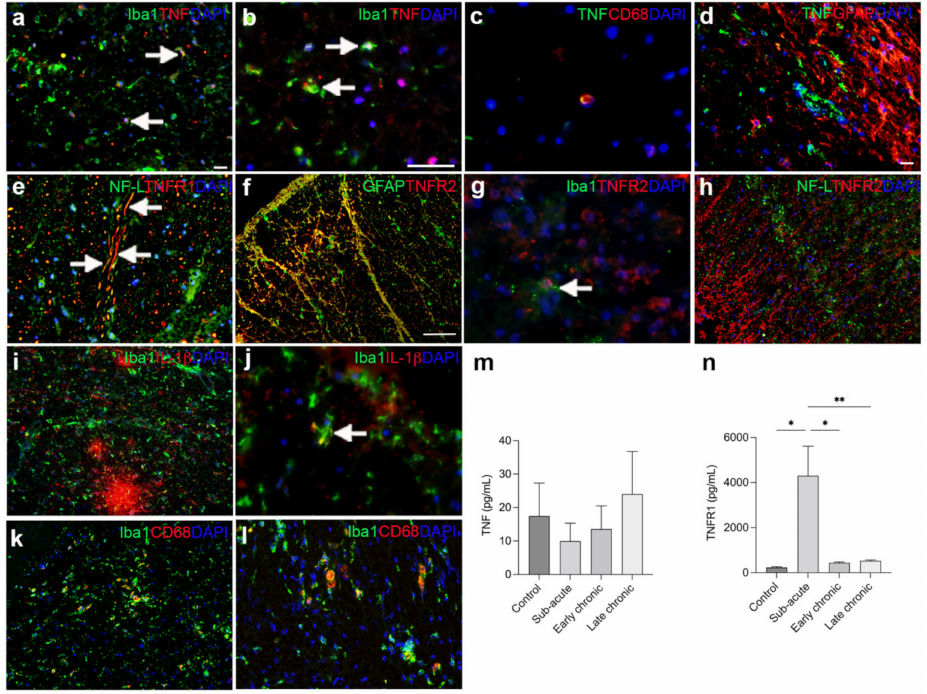
Figure 8. Characterization of TNF and TNFR in individuals with SCI. ( a , b ) Immunofluorescent double labeling of TNF (red) and Iba1 (green) expressing microglia/macrophages (arrows) in the spinal cord of an 33-year-old man with a 3-week-old C6–7 SCI. ( c ) Immunofluorescent double labeling of TNF (green) and CD68 (red) phagocytic cells in the spinal cord of an 65-year-old man with a 5-week-old C5 SCI. ( d ) Immunofluorescent double labeling of TNF + (green) cells and GFAP + astrocytes (red) in a 61-year-old man with a 2-week-old C1-2 SCI. ( e ) Immunofluorescent double labeling of TNFR1 + (red) and NF-L + (green) neuronal fibers in an 67-year-old man with a 6-week-old C5-7 SCI. ( f ) Immunofluorescent double labeling of TNFR2 (red) and astroglial GFAP (green) in an 80-year-old woman with a 2-month-old C8-T1 SCI. ( g ) Immunofluorescent double labelling of TNFR2 + (red) and Iba1 + (green) microglia (arrow) in a 67-year-old man with a 6-week-old C5-7 SCI. ( h ) Immunofluorescent double labeling of TNFR2 + (red) cells and NF-L + (green) neuronal fibers in an 33-year-old man with a 3-week-old C6-7 SCI. ( i , j ) Immunofluorescent double labeling of IL-1 β (red) and Iba1 (green) in a 65-year-old man with a 5-week-old C5 SCI. IL-1 β was found to co-localize to a subpopulation of Iba1 + microglia (arrow in h). ( k , l ) Immunofluorescent double labeling of CD68 (red) and Iba1 (green) in a 67-year-old man with a 6-week-old C5-7 SCI ( k ) and a 33-year-old man with a 3-week-old C6-7 SCI ( l ). Scale bars: ( a , d , e , i , l ) = 20 µ m; ( b , c , g , j ) = 40 µ m; ( f , g , h ) = 100 µ m. ( m , n ) CSF TNF ( m ) and TNFR1 ( n ), Time: F 3,30 = 10.33, p = 0.003) levels in individuals with SCI. Results are expressed as mean ± SEM, n = 5–12/group, * p < 0.05,** p < 0.01. CD, cluster of differentiation; GFAP, glial fibrillary acidic protein; Iba1, ionized calcium-binding adaptor molecule 1; IL, interleukin; NF-L, neurofilament light chain; TNF, tumor necrosis factor; TNFR, TNF